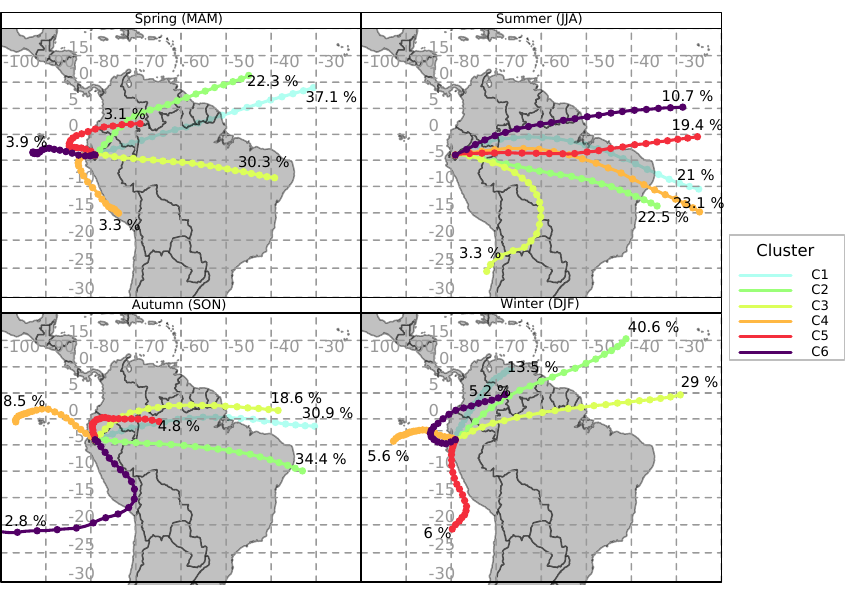
Figure 6. Seasonal mean back-trajectory clusters (C1–C6). Table 3. Mean sea salt concentration and percentage of total concentration for each season at the receptor site associated to the mean trajectory clusters (C1–C6) in the Andes of southern Ecuador. The percentage contribution of the mean clusters to the total concentration is shown in